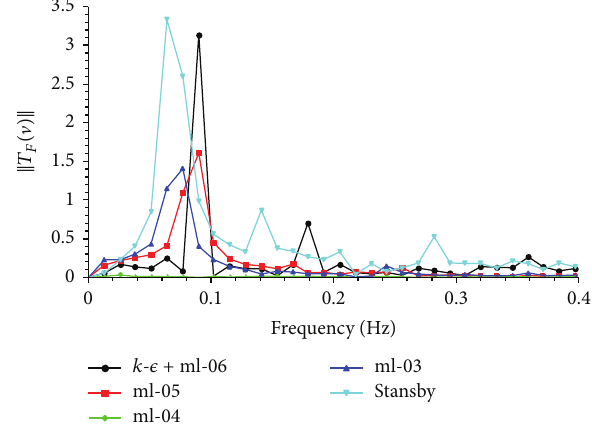
Figure 13: Velocity Fourier transformations